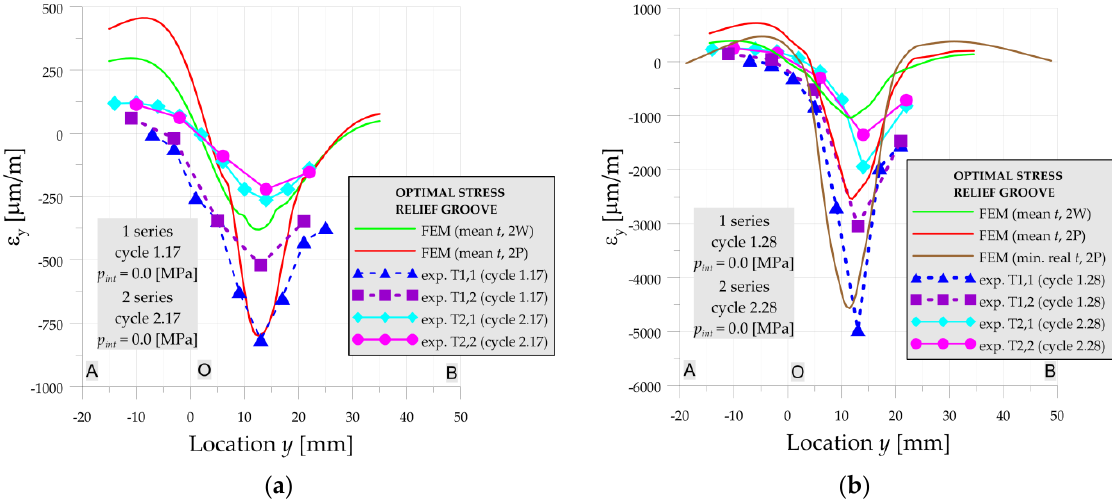
Figure 12. Numerical and experimental strains on line A-O-B, optimal SRG, 1st and 2nd series: ( a ) cycle 17; ( b ) cycle 28.